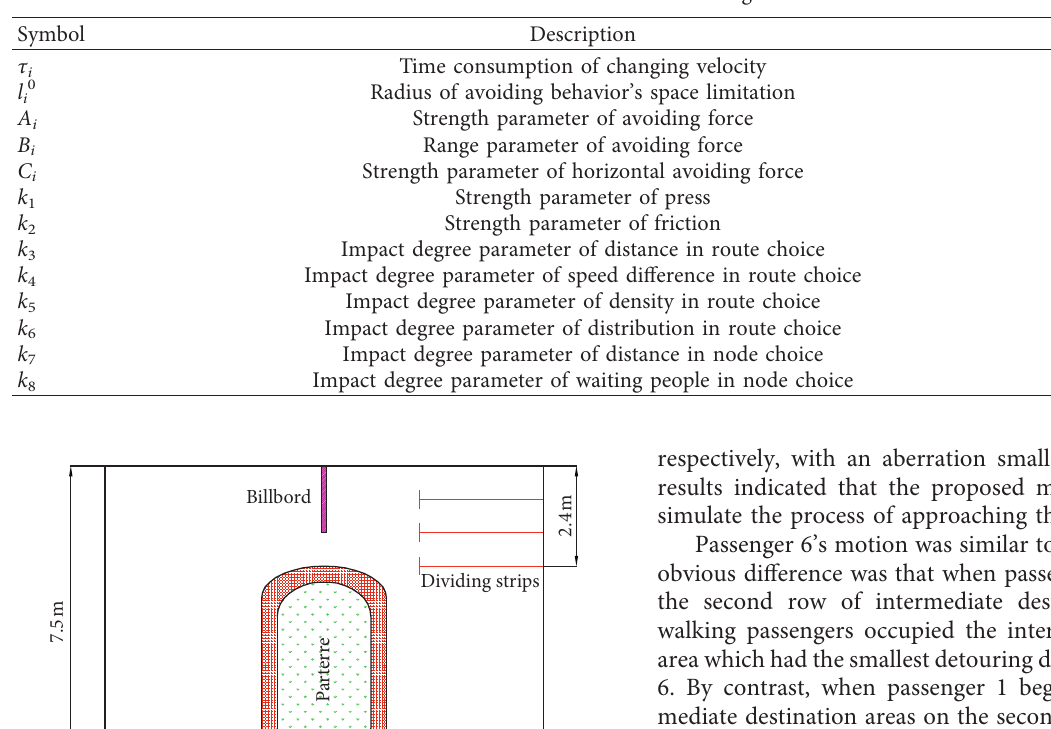
Table 2: Parameter settings.